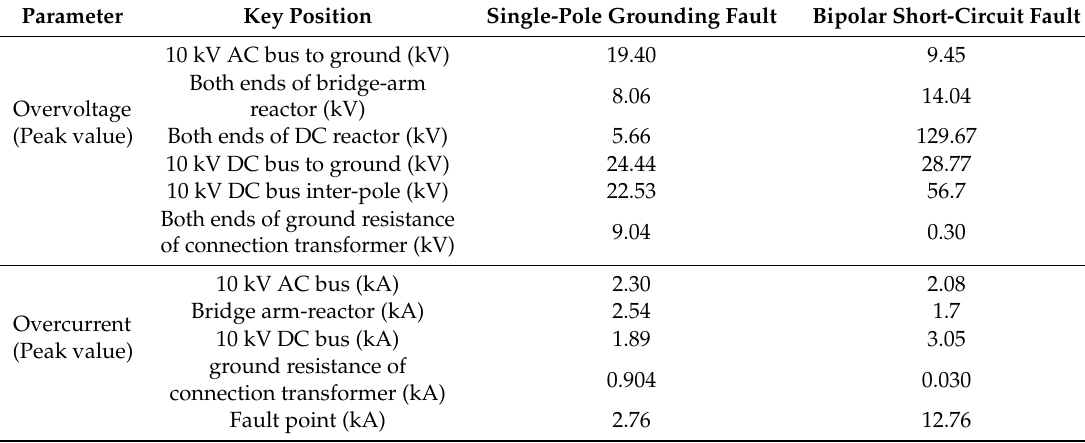
Table 8. Overvoltage and overcurrent levels of di ff erent positions during the DC system side fault. Parameter Key Position Single-Pole Grounding Fault Bipolar Short-Circuit